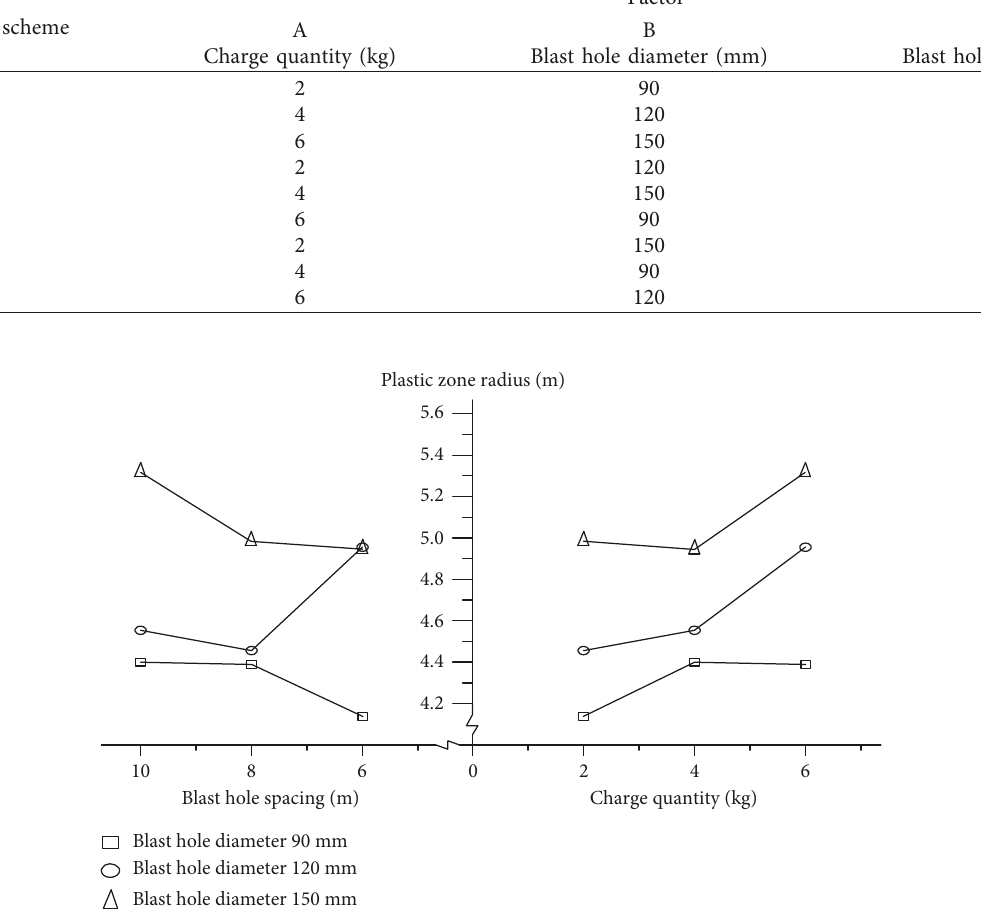
Figure 16: Relationship between various factors and the radius of the plastic